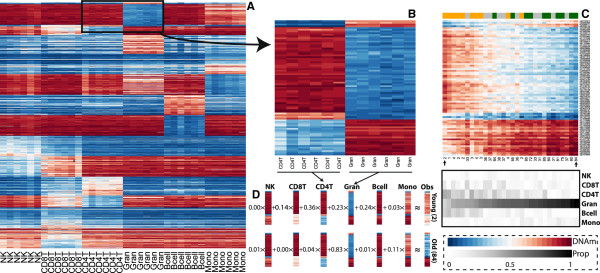
Illustration of how blood composition drives observed age differences. (A) Heatmap of the cell sorted data shows very clear and consistent DNAm profiles for each cell type. We show 600 probes selected for estimating composition proportions used to demonstrate differences here. (B) To simplify the illustration we selected a section of (A) displaying only the two most abundant cell types: CD4+ T cells and granulocytes. (C) Heatmap of a randomly selected sample of 30 whole blood samples (from the data in Additional file 1) across three age groups (10 per group): between 1 and 5 years of age, between 30 and 40, greater than 60 years. The same probes as in (B) are used. When the samples are ordered by their estimated granulocyte proportion, the samples roughly cluster by age and a similar pattern to (B) is observed. The estimated cell count proportions for each of the samples are shown below. Note the strong confounding between age and cell composition. (D) For the two samples highlighted with an arrow in (C), we show how a weighted average of the cell type profiles can reconstruct the observed DNAm profiles. The numbers shown are the estimated proportions. Note how different weights (cell counts) for old and young result in very different observed DNAm patterns. Note that the differences in CD4+ T cells and granulocytes drive much of the differences in DNAm. NK, CD56+ natural killer cells; CD8T, CD8+ T cells; CD4T, CD4+ T cells, Gran, granulocytes; Bcell, CD19+ B cells; Mono, CD14+ monocytes; DNAm, proportion of DNA methylation at individual CpGs (Illumina 'beta' values, bound between 0 and 1); Prop, cell count proportion, between 0 and 1 for each component, such that they sum to 1.